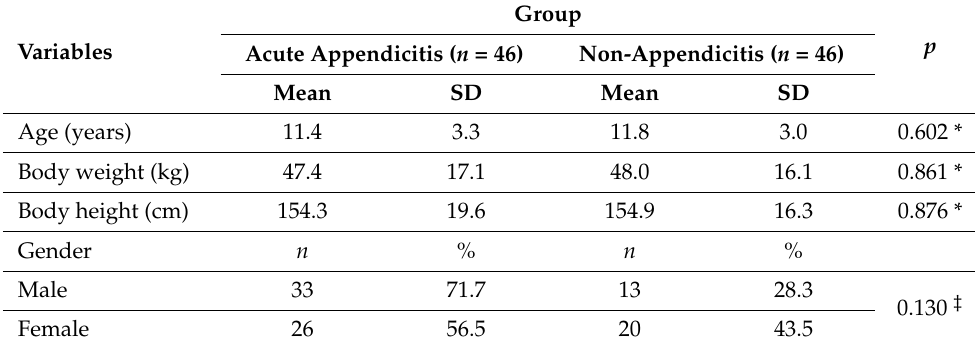
Table 1. Demographic data of the